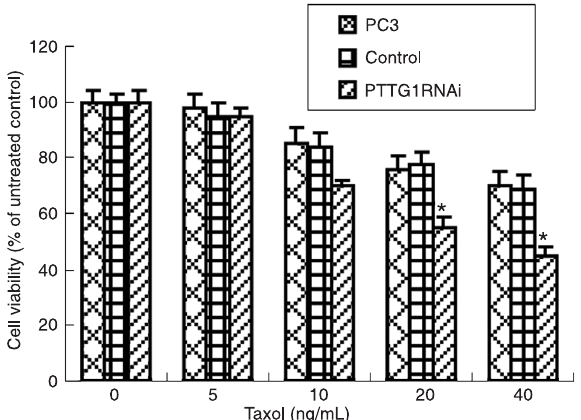
Figure 5. Viability of pituitary tumor-transforming gene-1 RNAi (PTTG1RNAi), vector controls and parental PC3 after exposure to taxol as determined by the MTT assay. Cells were seeded on 96-well plates and drugs were added 24 h later. Cell viability was examined 24 h after treatment. Results are reported as the absorbance ratio of treated and untreated cells. Note that cell viability of PTTG1RNAi is lower than that of the vector controls and parental PC3. *P < 0.05 compared to the vector control and parental PC3